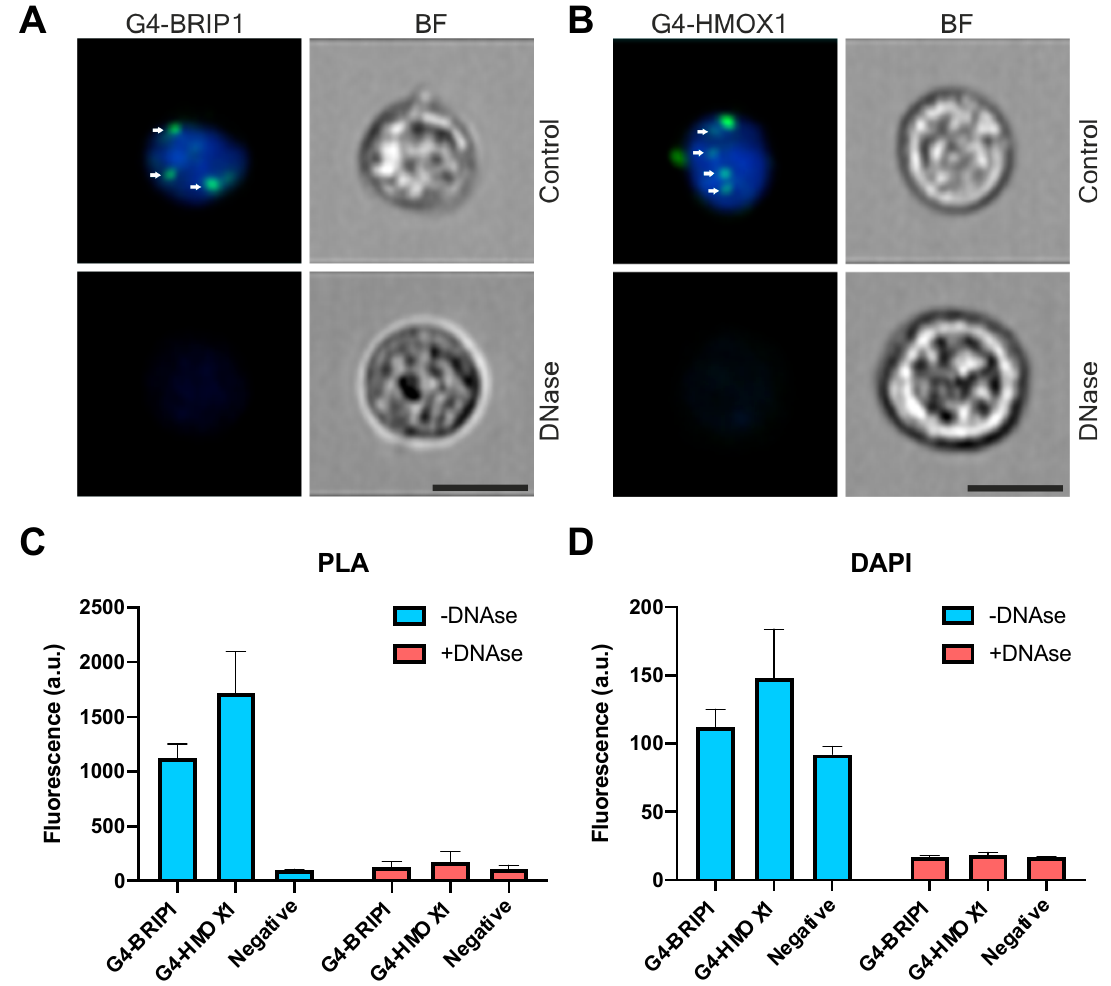
Figure 6. Detection and quantification of the PLA signal at a single-cell level in HEK293T cells using flow cytometry. ( A ) G4-BRIP1 and ( B ) G4-HMOX1 interactions (green dots) were visualized in the control group and after DNase digestion. Most of the G4 interactions were localized in the nucleus (arrows) but some also appeared in the cytoplasm. Nuclei were counterstained with DAPI (blue), where the transmission bright-field images (BF) show the cell morphologies. Cells were fixed in methanol and mouse 1H6 antibodies were used. Scale bars: 10 μ m. ( C ) Mean fluorescence of G4-BRIP1 and G4-HMOX1 PLA signal and ( D ) DAPI in the control cells and after DNase digestion. Negative controls were cells stained with secondary antibodies only. Data is shown as mean + SEM (standard error of the mean)